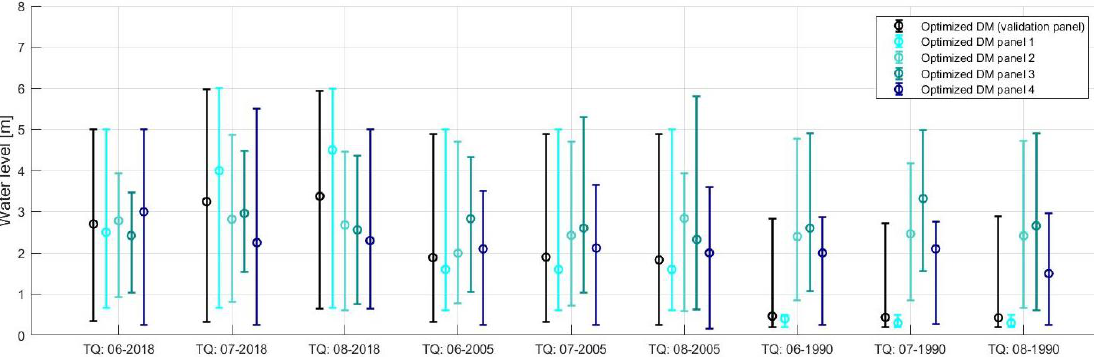
Figure 4. A comparison of the optimized Decision Makers of the different panels based on the 9 overlapping target questions. The circles indicate the final estimate given by the optimized DM. The 5% and 95% quantiles are also